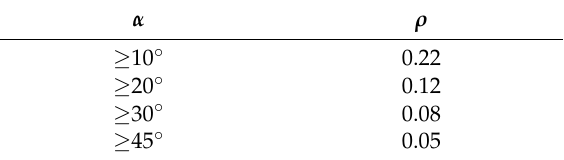
Table 3. Dependence of a water reflection coefficient on the angle of height of the